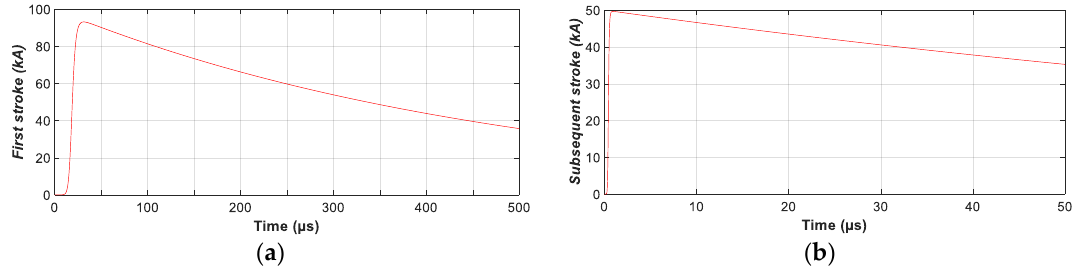
Figure 4. Lightning current waveforms according to IEC 62305-1 [67]: ( a ) first negative short stroke for lightning protection level (LPL) I ; ( b ) subsequent negative short stroke for LPL I .